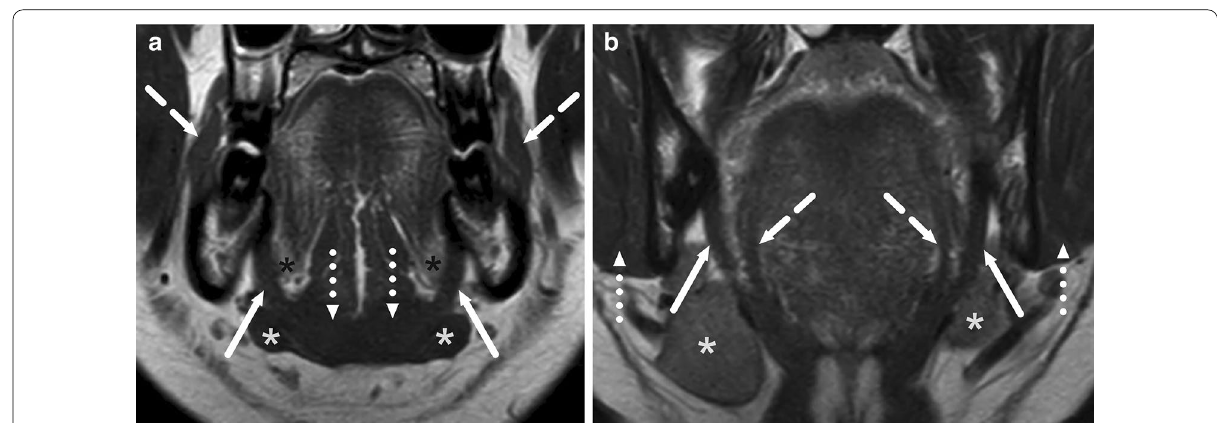
Fig. 3 Normal MRI anatomy of the oral cavity. a A coronal T2-weighted image at the anterior part shows the mylohyoid muscle (arrow), separating the sublingual space superiorly including the sublingual gland (black asterisk) and the submandibular space inferiorly. Medially, and superior to the mylohyoid muscle, are the geniohyoid muscles (dotted arrow) and genioglossus muscles (superior to the geniohyoid muscles). Inferiorly, images show the anterior belly of the digastric muscle (white asterisk), and laterally, the buccinator muscle (dashed arrow). b A coronal T2-weighted image at a more posterior part shows the mylohyoid muscles (arrow) and the hyoglossus muscles more medially (dashed arrow), and the masseter muscle laterally in the masticator space (dotted arrow). Submandibular glands (asterisk) are shown below the mylohyoid